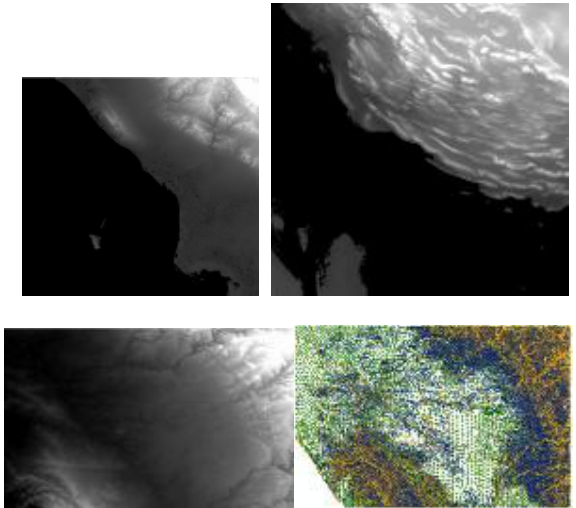
Figure 2.Up: ASTER GDEM ver2 (left), SRTM (right), Down: local DEM (left), Topographical map layers (right) Table 1 gives summary information of three elevation models.